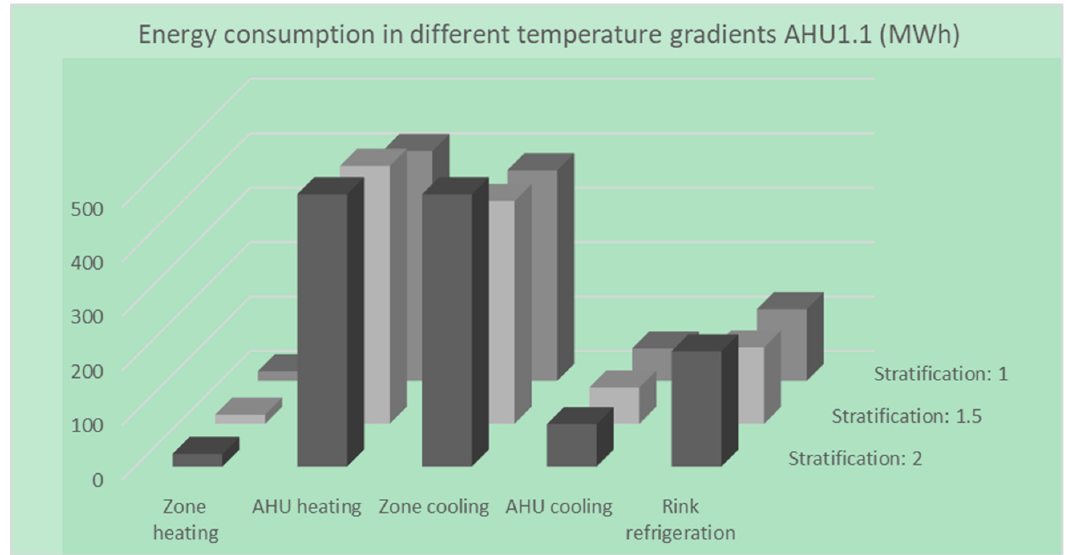
Figure 17. Energy consumption of different temperature gradients, AHU1.1.